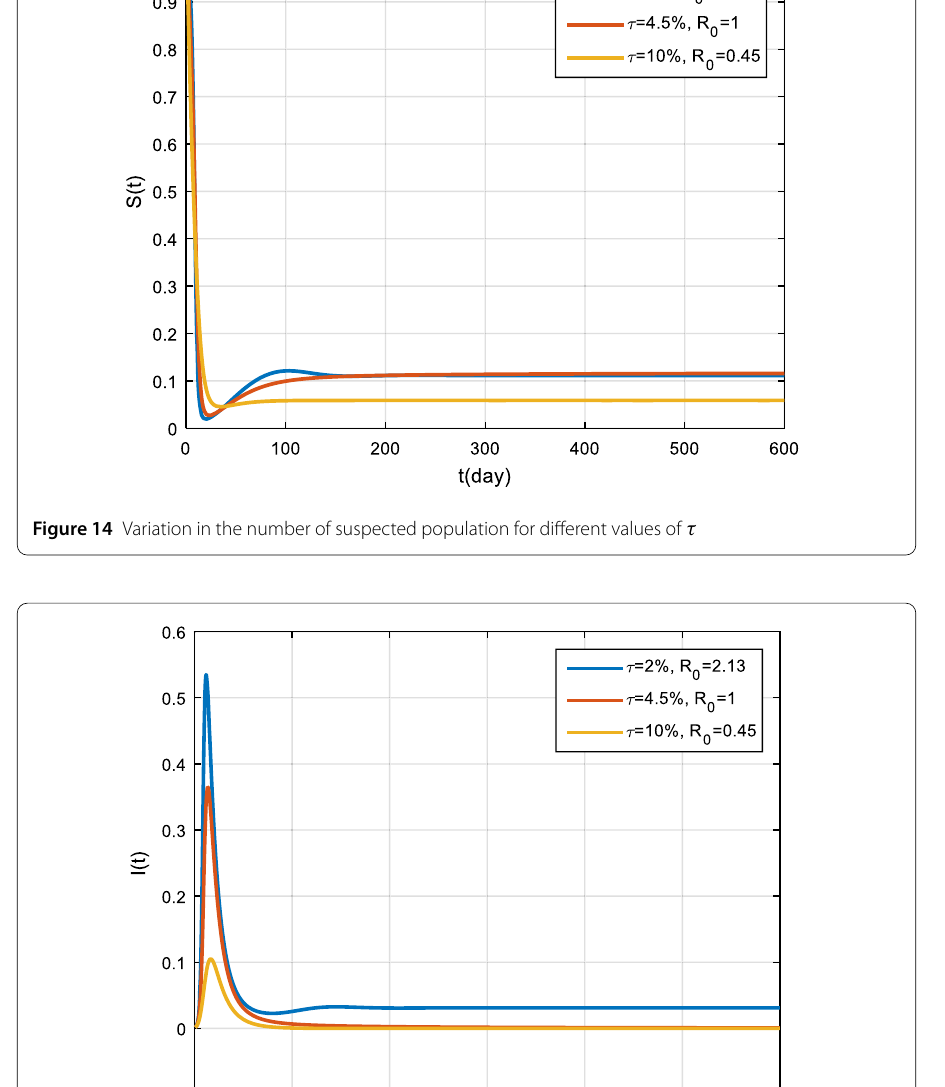
The simulation results of obedience in implementing health protocols are presented in Fig. 14, Fig. 15, and Fig. 16. Based on these figures, if obedience in implementing health protocols is only 2%, then COVID-19 will become endemic in the population. However, if obedience to follow health protocols is more than 4.5%, then the COVID-19 outbreak will vanish in the population. From the simulation results of vaccine effectiveness and the level of adherence to follow health protocols, it can be seen that, for the same π and τ values, the results will be the same. This shows that vaccination and the implementation of health protocols have the same effect on the spread of COVID-19 in